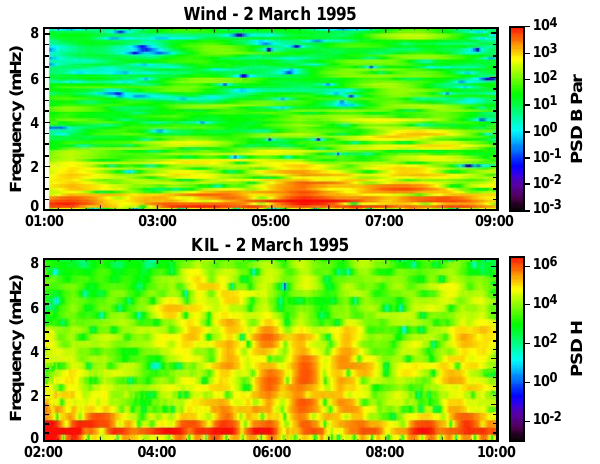
Fig. 17. PSD for Wind (top panel) and KIL (bottom panel) on 2 March